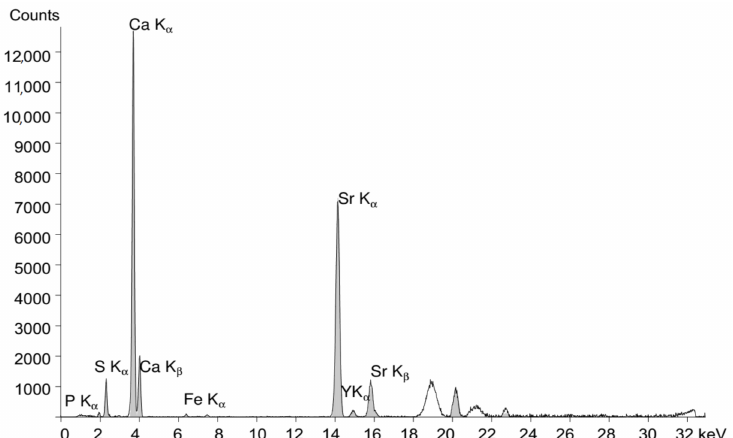
Figure 7. The element spectrum of phosphogypsum sample [70].